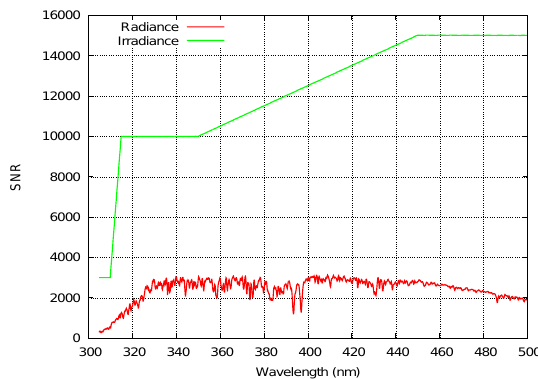
Fig. 5. Expected signal-to-noise ratios of the UVN instrument in the UV-VIS band. The irradiance SNR shown is the